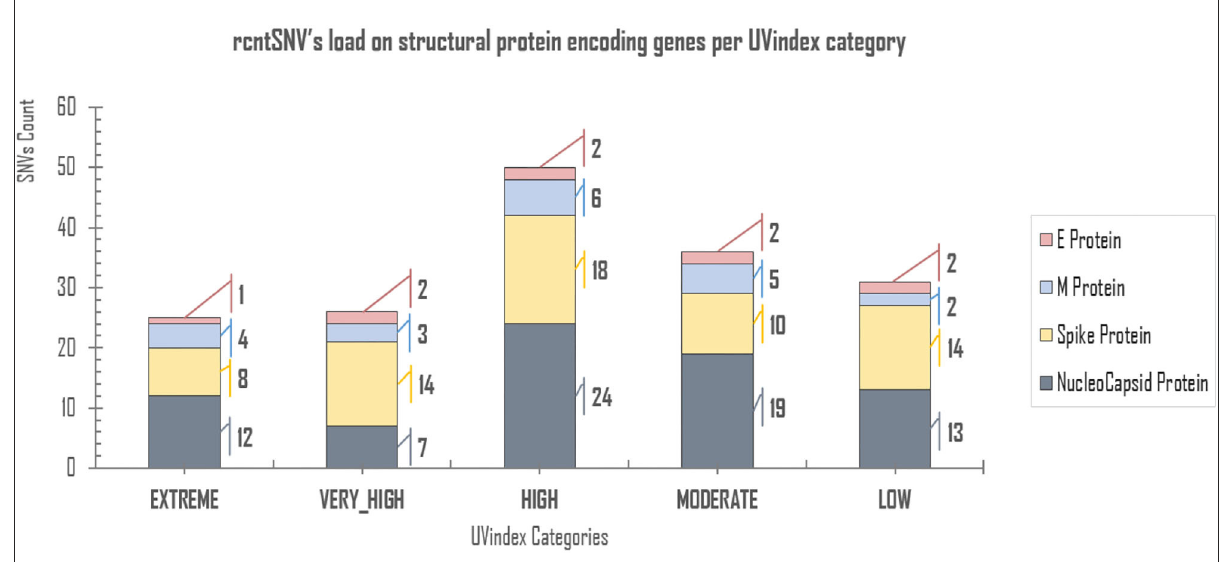
FIGURE3 rcntSNVs load on structural protein-encoding genes per UVindex category. Each UVindex category is represented by a stacked column, whereas the bars in gray, yellow, blue, and pink represent numbers of recurrent SNVs in nucleocapsid (N), spike (S), membrane (M), and envelope (E) structural protein-encoding genes, respectively. For each UVindex categories, the rcntSNVs count for all proteing-encoding genes are given on the right-hand side of stacked-bars.